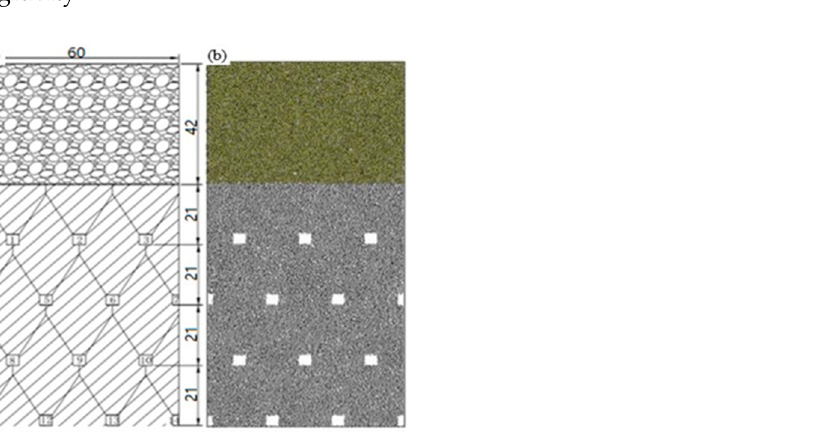
Figure 3. Schematic of the model: ( a ) schematic of model size, m; ( b ) 2D numerical model diagram. A total of 41,331 balls are found in the model, where 35,093 red balls represent the ore, and 6238 yellow balls represent the waste rock. The particle unit diagram of the 2D numerical simulation of the ore drawing scheme is shown in Figure 3b.